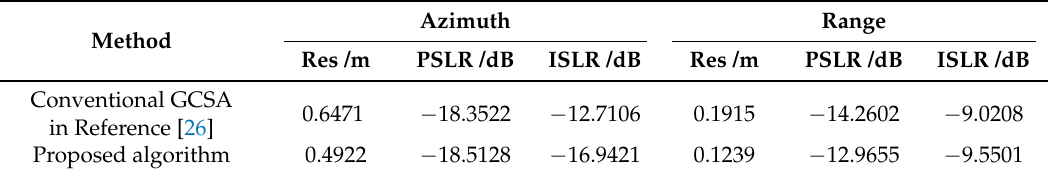
Figure 9. Focused results of point scatterers for L-band SAR data at 80% fractional bandwidth, using the generalized chirp scaling algorithm (GCSA) and proposed algorithm. ( a – c ) Conventional GCSA. ( d – f ) Proposed algorithm. The three subgraphs of each row correspond to the contour maps, range profiles and azimuth profiles, respectively. The dynamic range of contour is − 35 dB ∼ 0 dB. Table 3. Measured parameters of imaging results for Figure